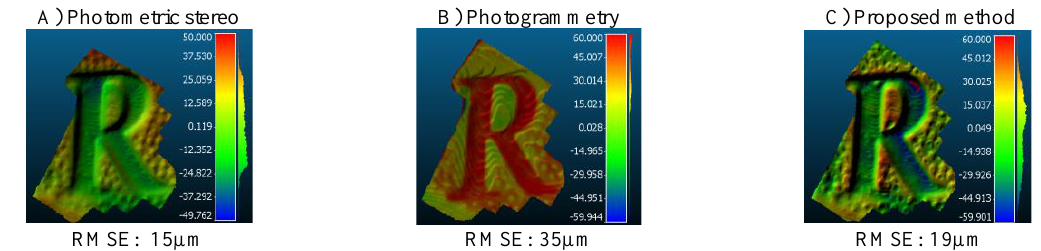
Figure 6. Evaluation results for the high-frequencies on Object 03: cloud-to-cloud comparisons using reference data for photometric stereo, photogrammetry and the proposed approach on the small 2.5mm * 3mm patch of the